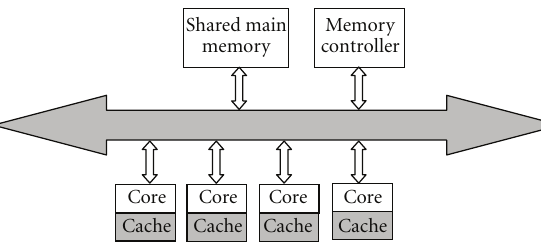
Figure 7: Proposed private cache